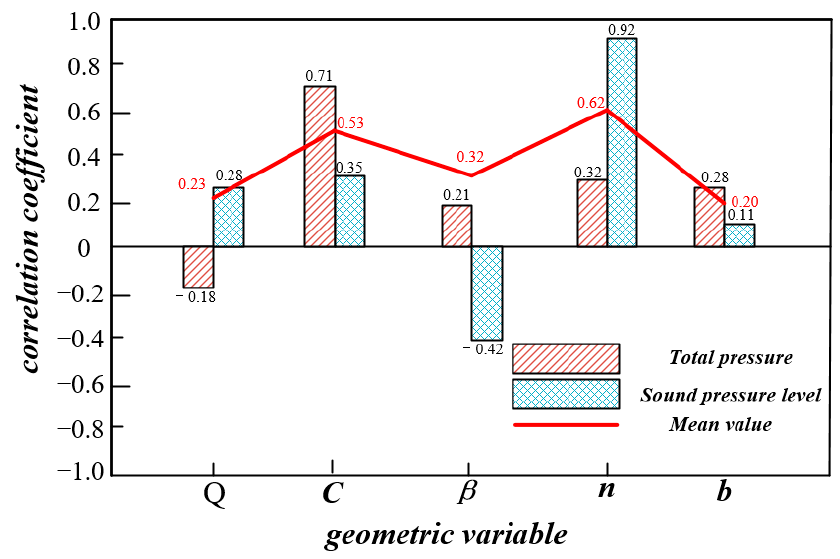
Figure 8. The correlation between optimization variables and optimization objectives.